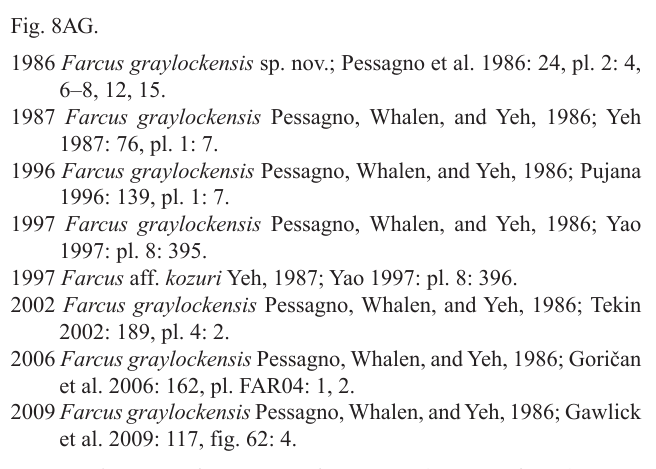
Fig. 9. SEM images of radiolarians, Mount Rettenstein, Austria, Pliensbachian, Early Jurassic. A – D . Anaticapitula anatiformis (De Wever, 1982a). A . Sample Rö416. B , C . Sample Rö37. D . Sample Rö38. E . Anaticapitula parvireticulata Bertinelli and Marcucci, 2011, sample Rö417. F . Dumitricaella